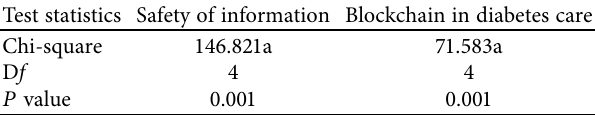
Table 5: Chi-square test between enhancing transparency and usage of blockchain in diabetes care for elderly patients.